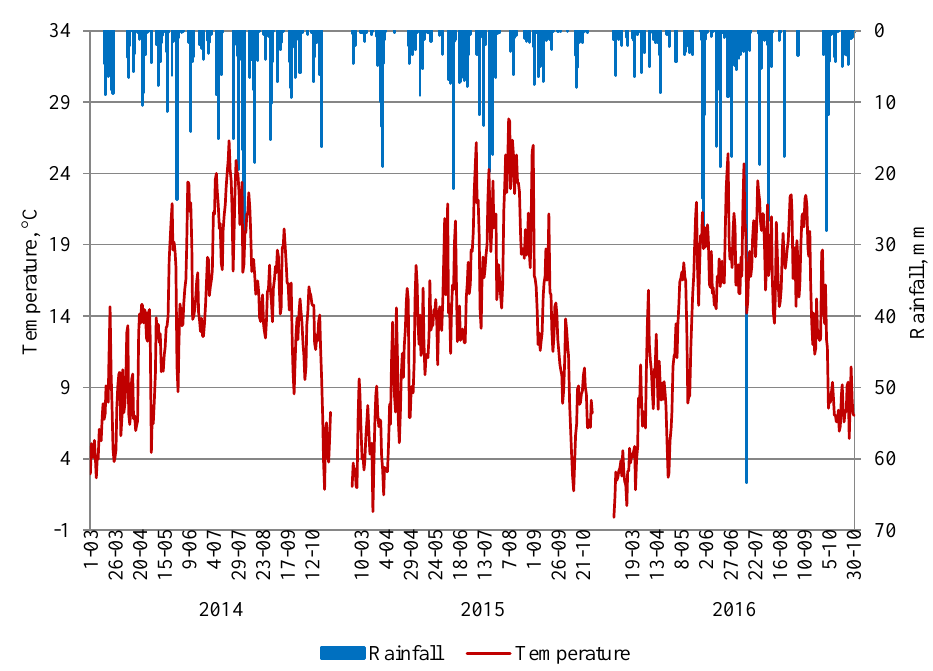
Figure 1. Mean daily air temperature and precipitation during the 2014–2016 growing seasons, measured at the Synoptic Station at Brody.